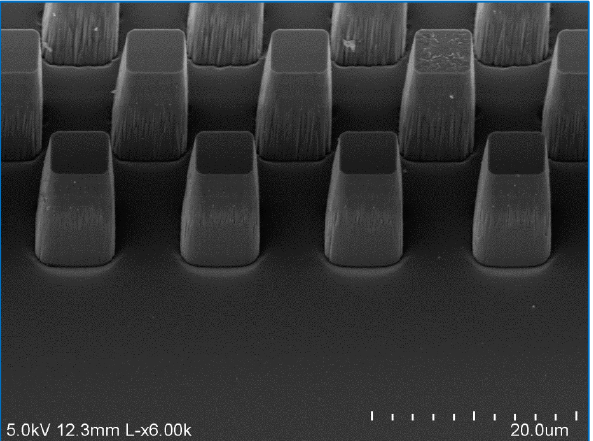
Figure 2. ( a ) SEM of a uniform KMPR 1005 layer after developing step; and ( b ) SEM of the etched fused silica.